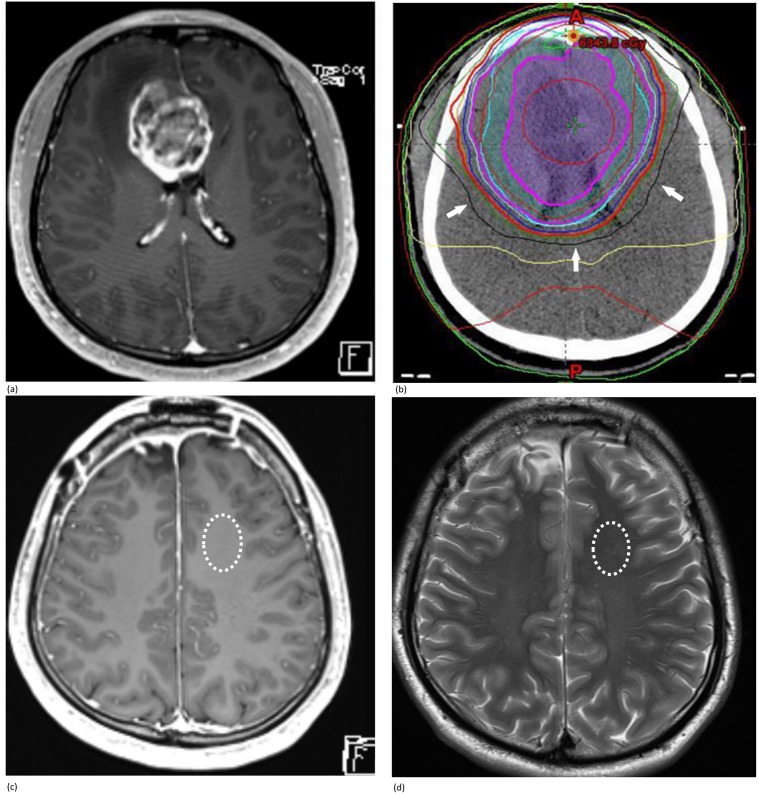
ROI around primary tumors.A 28-year-old male patient with severe headache for 1 month underwent brain MR imaging. (a) Contrast-enhanced axial T1WI revealed a heterogeneous enhancing mass located at the right frontal lobe. He underwent gross total removal of the brain tumor, and final pathology confirmed GBM. He also completed radiotherapy (total dose = 61.2 Gy). (b) The black line (arrows) in the radiotherapy plan map showed the iso-dose line of 3600 cGy, which was the 56.7% iso-dose line of the maximum dose (6343.8 cGy). For R1 measurement, the ROI was drawn at the peri-tumoral area located within the 50–100% iso-dose line of the maximum dose and both (c) overt enhancing area and (d) abnormal T2 hypersignal intensity area were avoided.